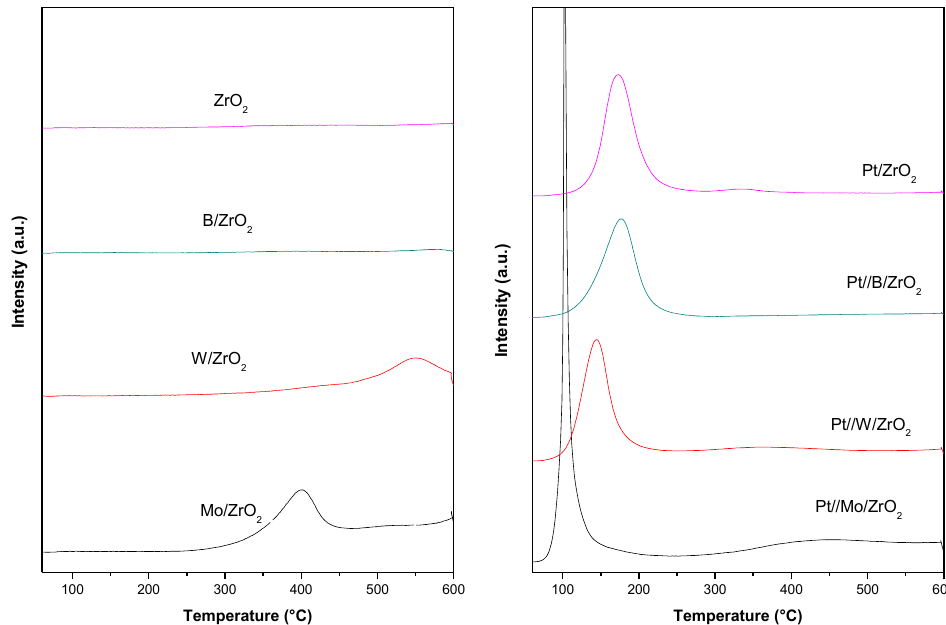
Figure 2. Temperature-programmed reduction (TPR) profiles for supports ( left ) and supported Pt catalysts ( right Figure 2. TPR profiles for supports (left) and supported Pt catalysts (right).